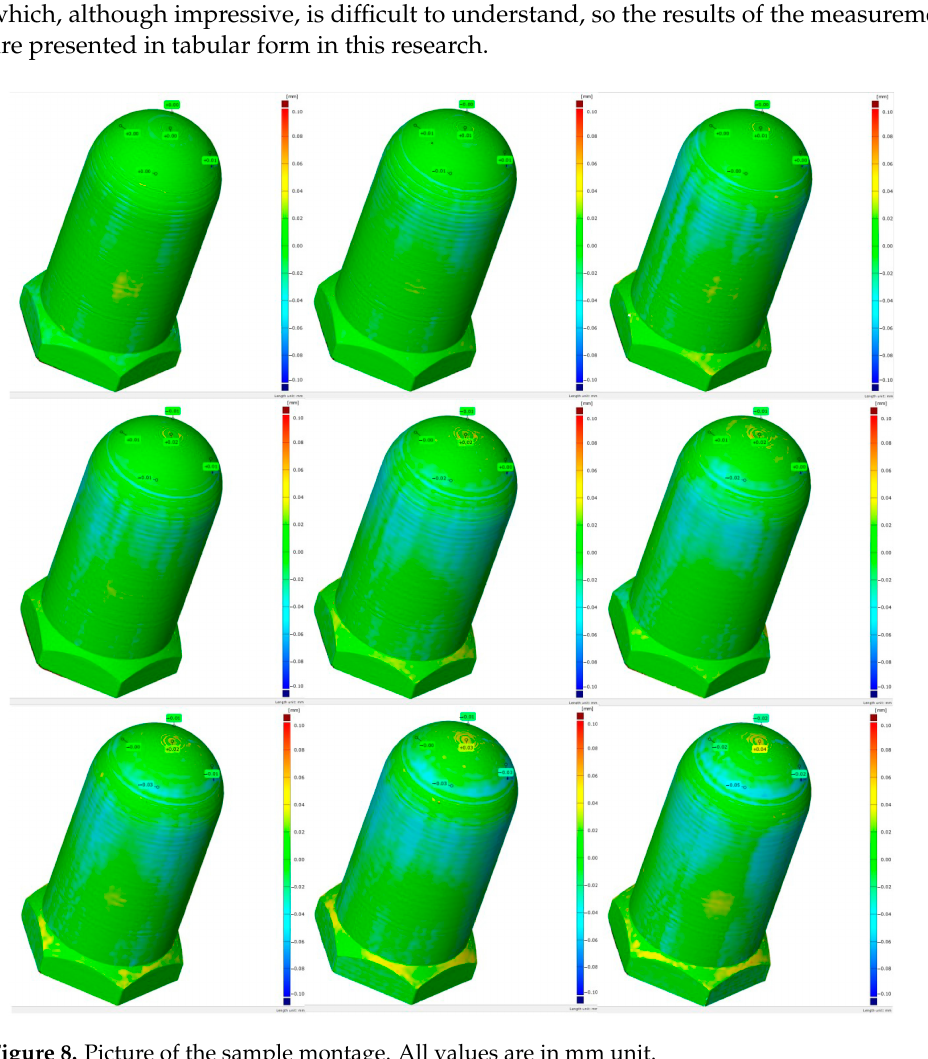
Figure 8. Picture of the sample montage. All values are in mm unit.